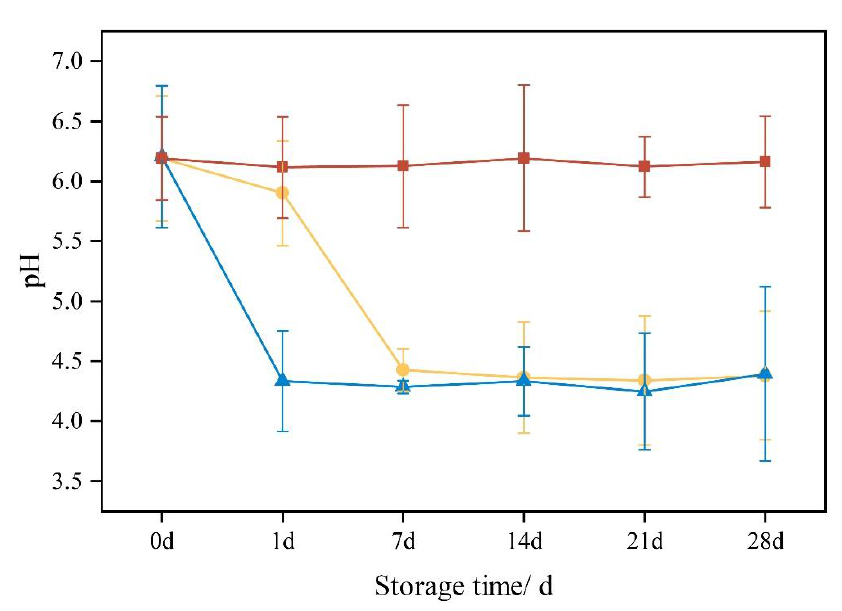
Figure 2. Change trend of pH value of lamb liver paste during storage period. Note: yellow repre- sents the natural fermentation group (NF); blue represents the starter fermentation group (SF); red represents the sterilization group (ST).